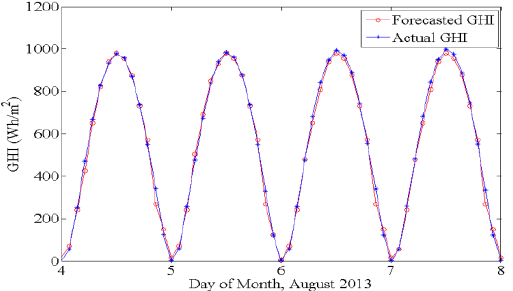
Figure 6. Comparison between two-days-ahead forecasted and actual GHI for clear 4 days (type 1).